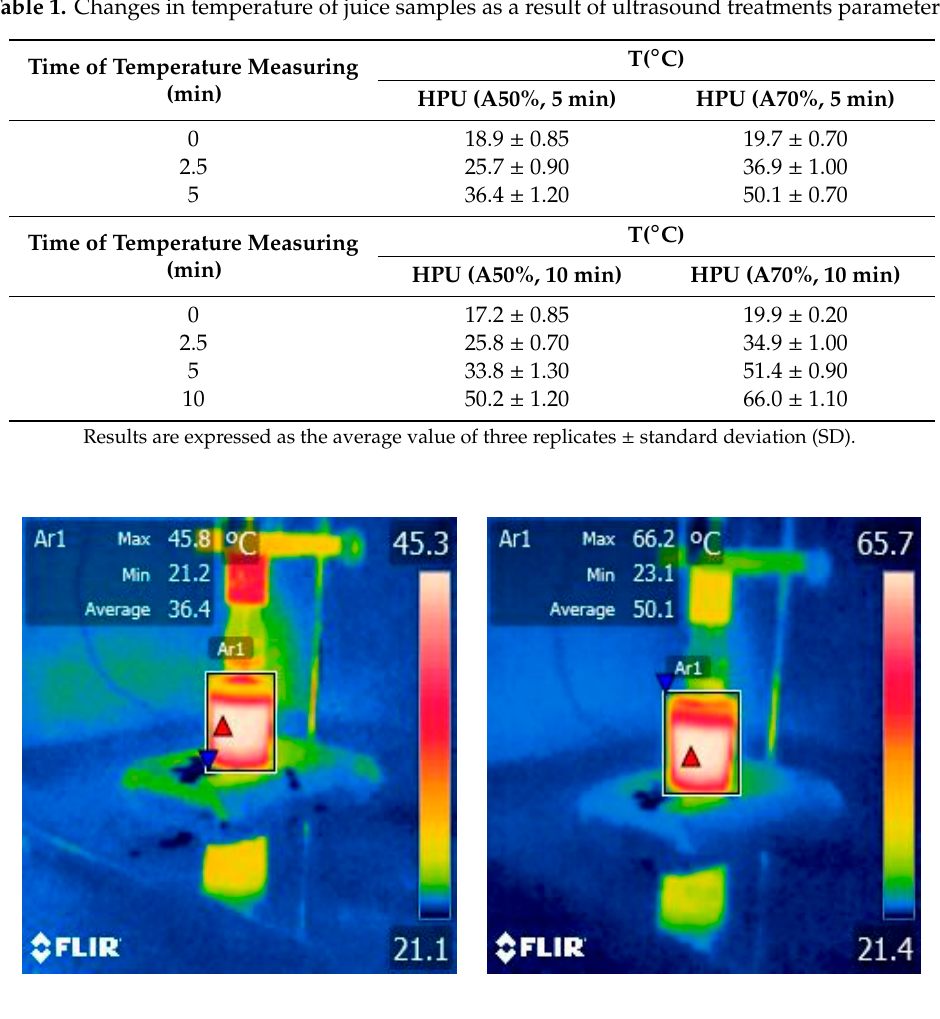
Table 1. Changes in temperature of juice samples as a result of ultrasound treatments parameters.